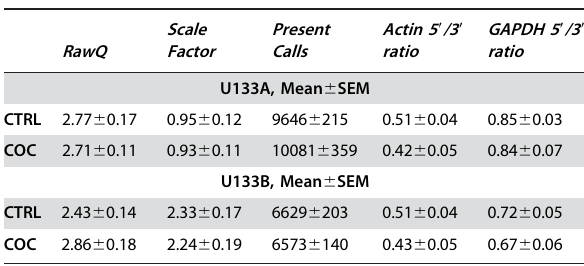
Table 2. Quality control parameters for brain